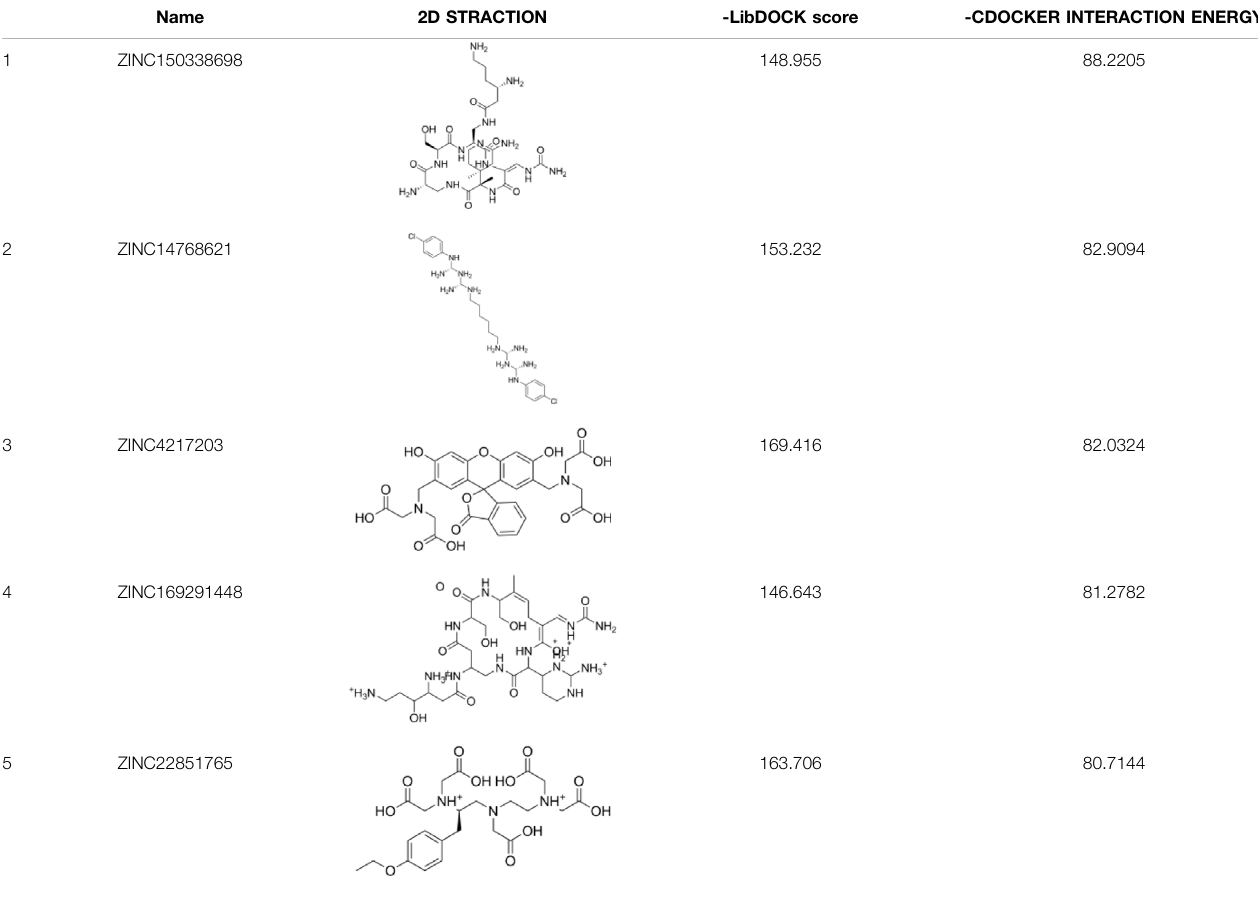
TABLE 1 | Top fi ve compounds from virtual screening